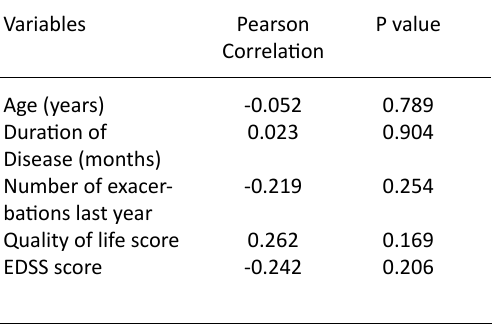
Fig. 2. Correlation between 25-hydroxyvitamin D3 level and EDSS score in patients with multiple sclerosis. Association between plasma 25-hydroxy Table 3. Correlations of the studied variable with the level of 25-hydroxy vitamin D3